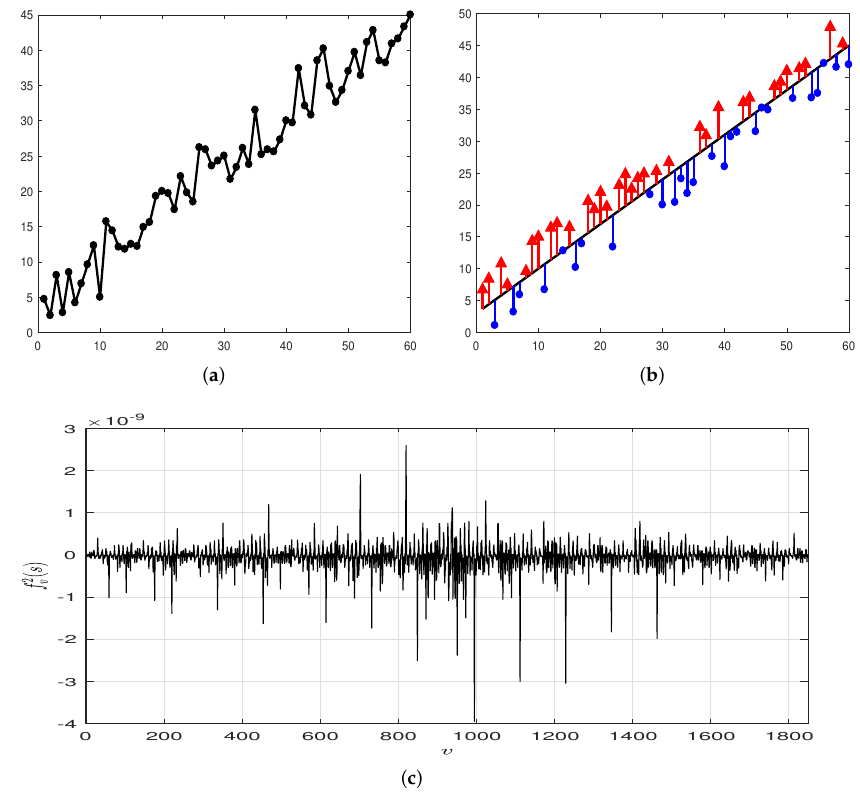
Figure 2. ( a ) The time series. ( b ) Fitting the time series. ( c ) f 2 v ( s ) obtained with traditional MF-S-DFA. A color version of the figure is available in the web version of the